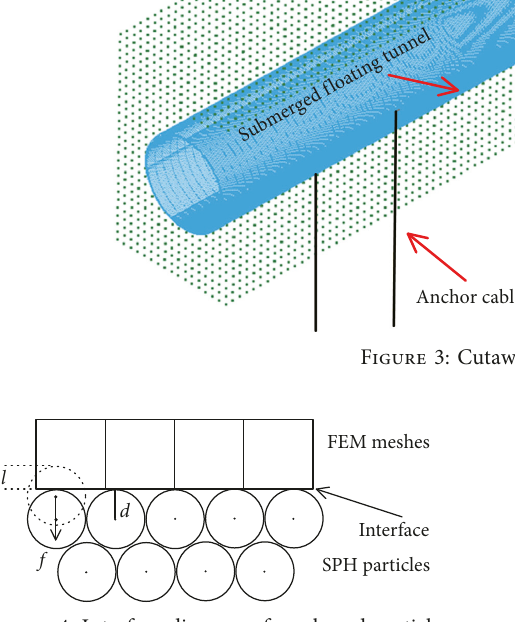
Figure 4: Interface diagram of mesh and